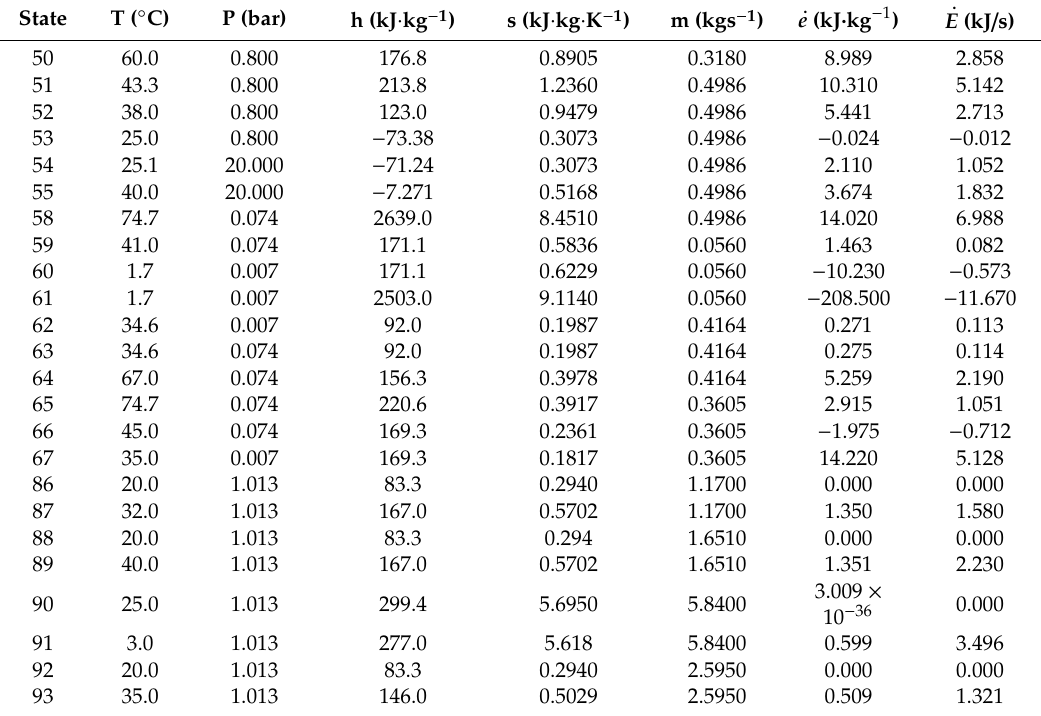
Table A4. Thermodynamic state point properties for the vapor absorption cycle in the IMP.